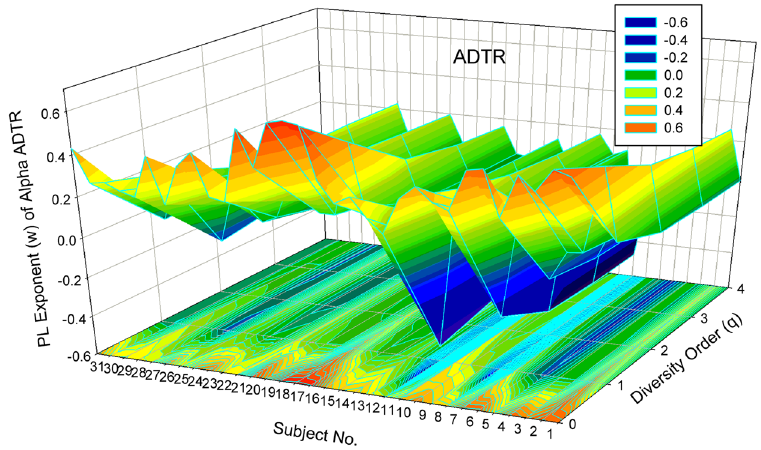
Figure 1. The 3D-graph of the power law exponent ( w ) of alpha - DTR.